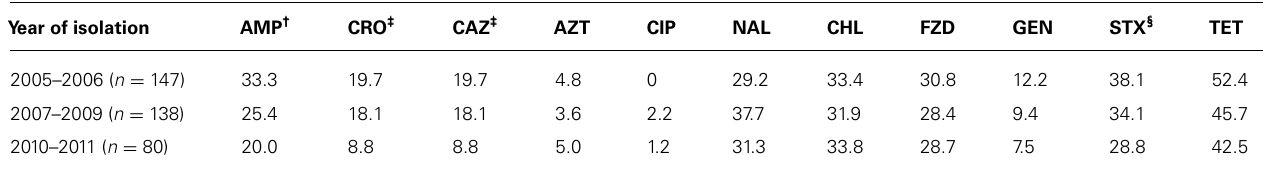
Table 2 |Antimicrobial susceptibility in Salmonella isolates from ill children inYucatan, Mexico, 2005–2011. Percentage of resistance*. Year of isolation